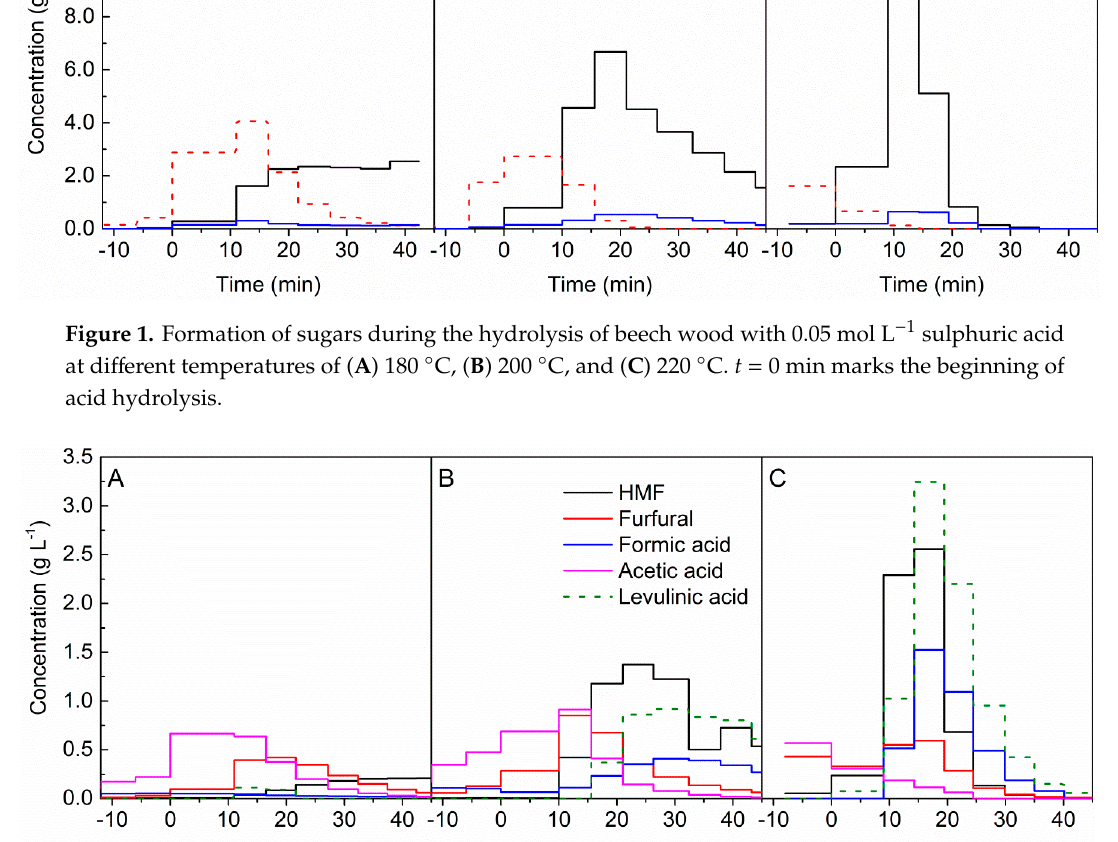
Figure 1. Formation of sugars during the hydrolysis of beech wood with 0.05 mol L − 1 sulphuric acid at different temperatures of ( A ) 180 °C, ( B ) 200 °C, and ( C ) 220 °C. t = 0 min marks the beginning of acid hydrolysis.